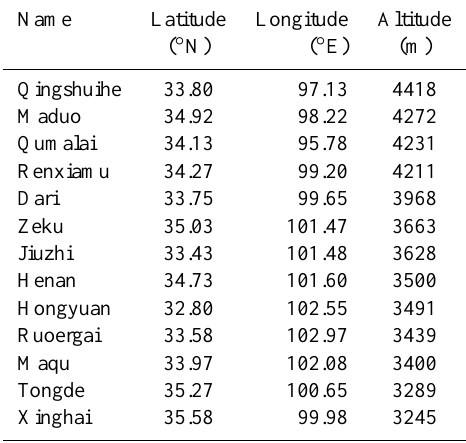
Table 1. Geographical characteristics of the climatic stations used in this